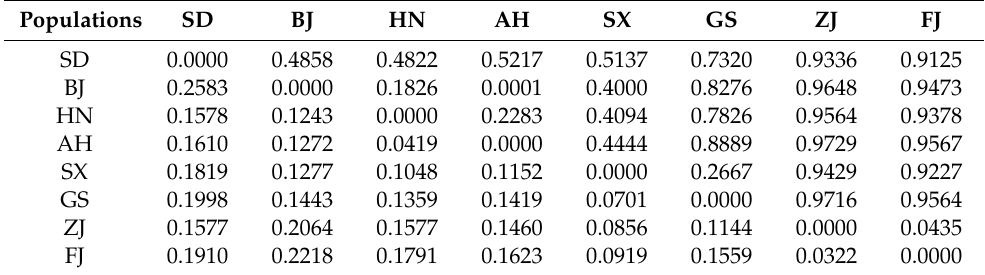
Table 3. Pairwise estimates of F ST based on 13 microsatellite markers (below diagonal) and two mtDNA markers (above diagonal). All pairwise comparisons of F ST values are statistically